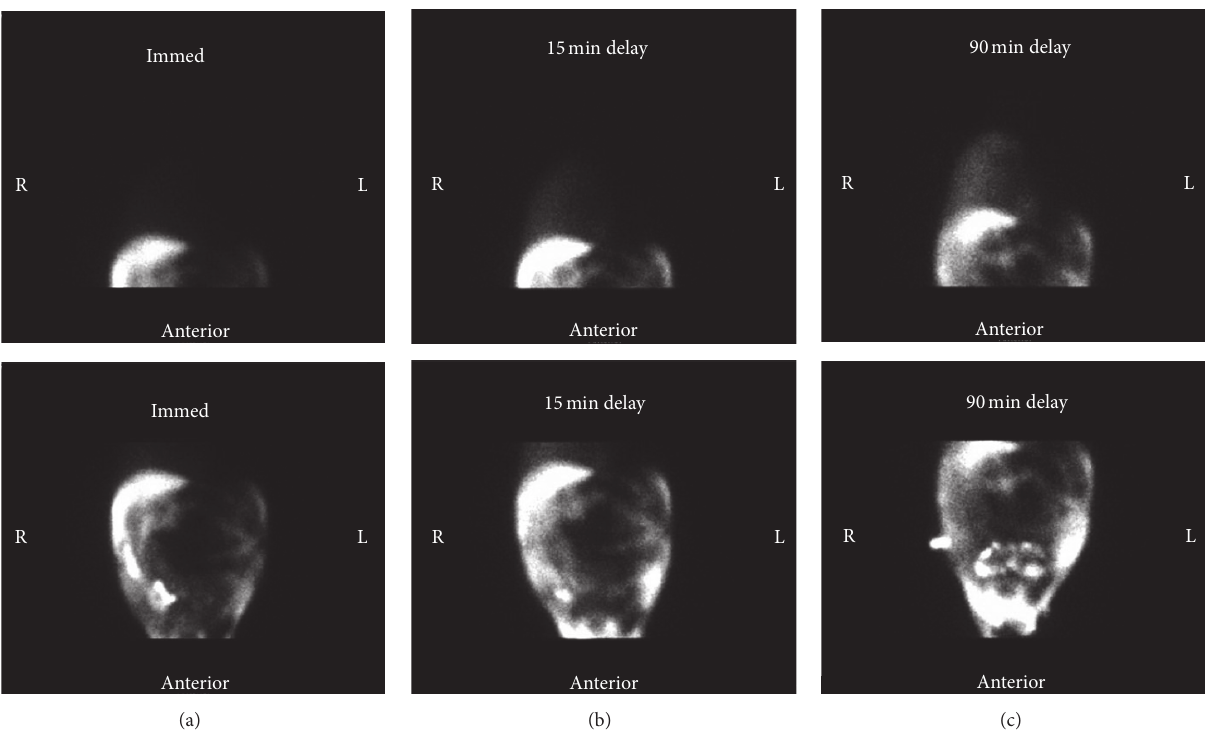
Figure2:Anteriorplanarnuclearimagesofthethorax(upperimages)andabdomen(lowerimages)obtainedafterradiotraceradministration with 99 m Technetium-labeled albumin into the peritoneal cavity. Images were obtained immediately after tracer injection (a) and at intervals of 15 minutes (b) and 90 minutes (c). Very faint radiotracer accumulation is evident in the right hemi thorax immediately (a) and is more pronounced at 15 minutes (b) and at 90 minutes (c). Radiotracer is seen to equalize in the abdomen over time (bottom images of (a), (b), and (c)). There is no visible tracer in the left hemi